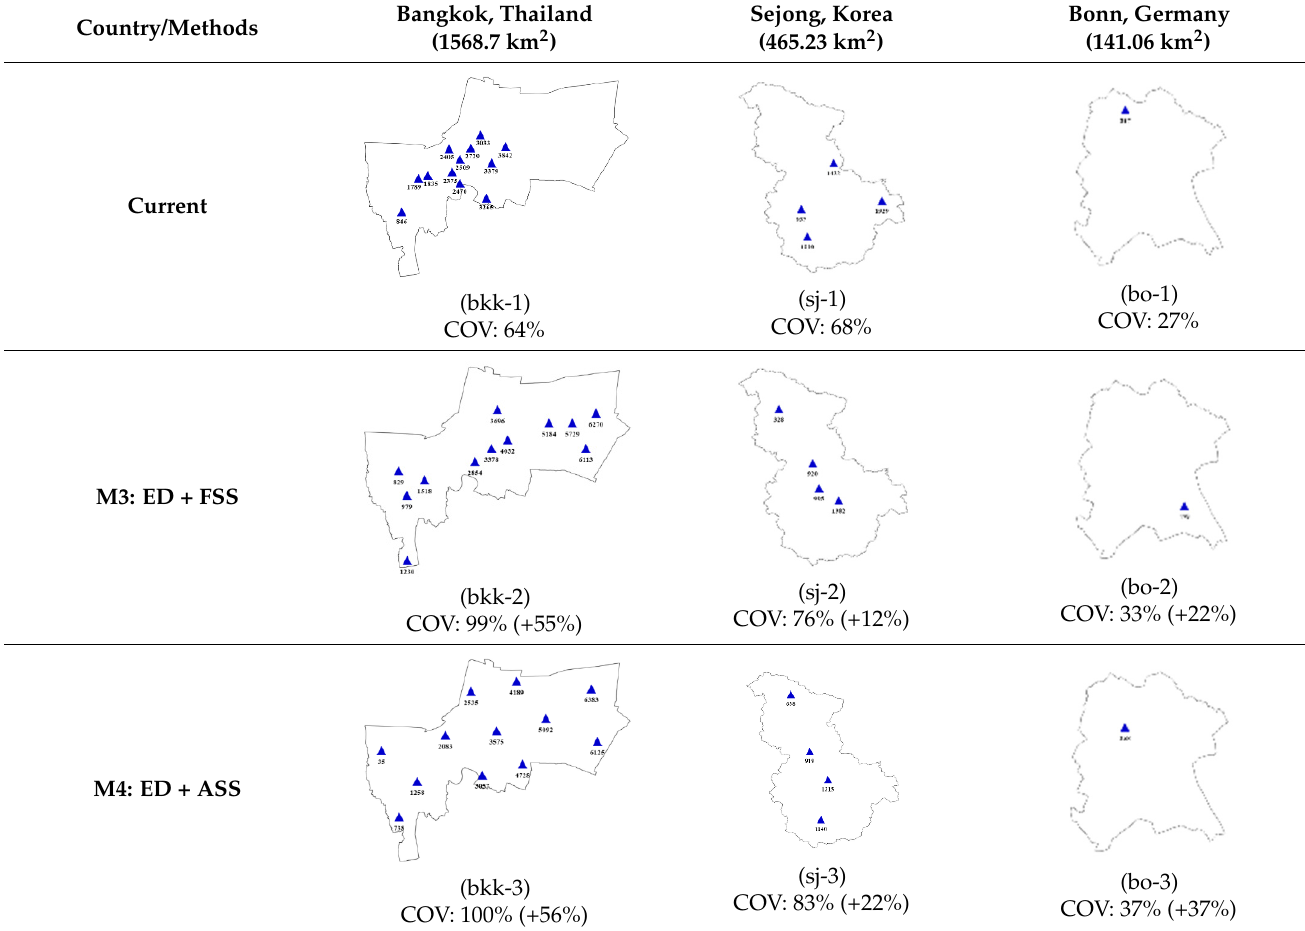
Table 6. Locations of stations within the cities and coverage percentages: (bkk-1), (sj-1), (bo-1) depict current stations, (bkk-2), (sj-2), (bo-2) depict station networks using M3: ED + FSS, and (bkk-3), (sj-3), (bo-3) depict station networks improved using M4: ED + ASS, in Bangkok, Sejong, and Bonn, respectively.